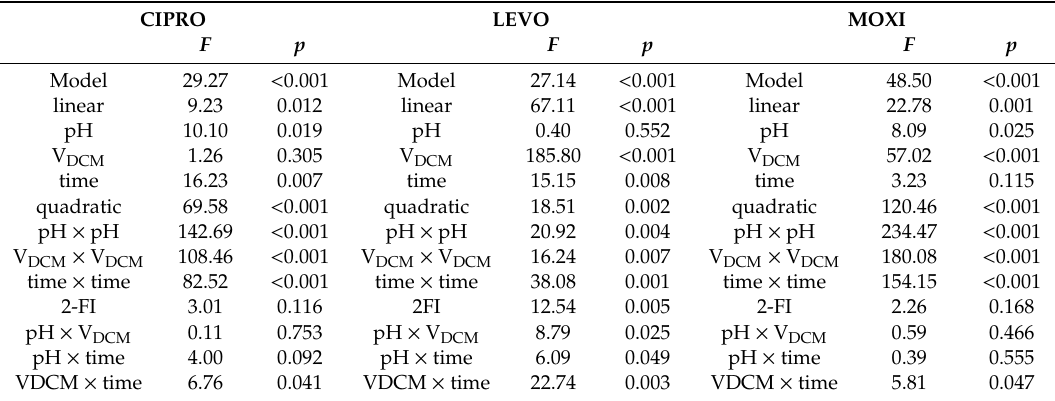
Figure 2. The RSM diagrams illustrating the change of recovery of CIPRO when analyzed: ( a ) VDCM and pH; ( b ) time and pH; ( c ) time and VDCM for CCD. Table 6. The statistical analysis of CCD for the analytes.